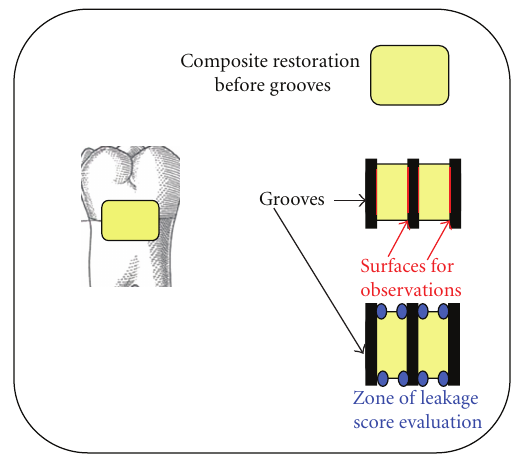
Table 3: Mean microleakage scores of the di ff erent tested adhesive systems.